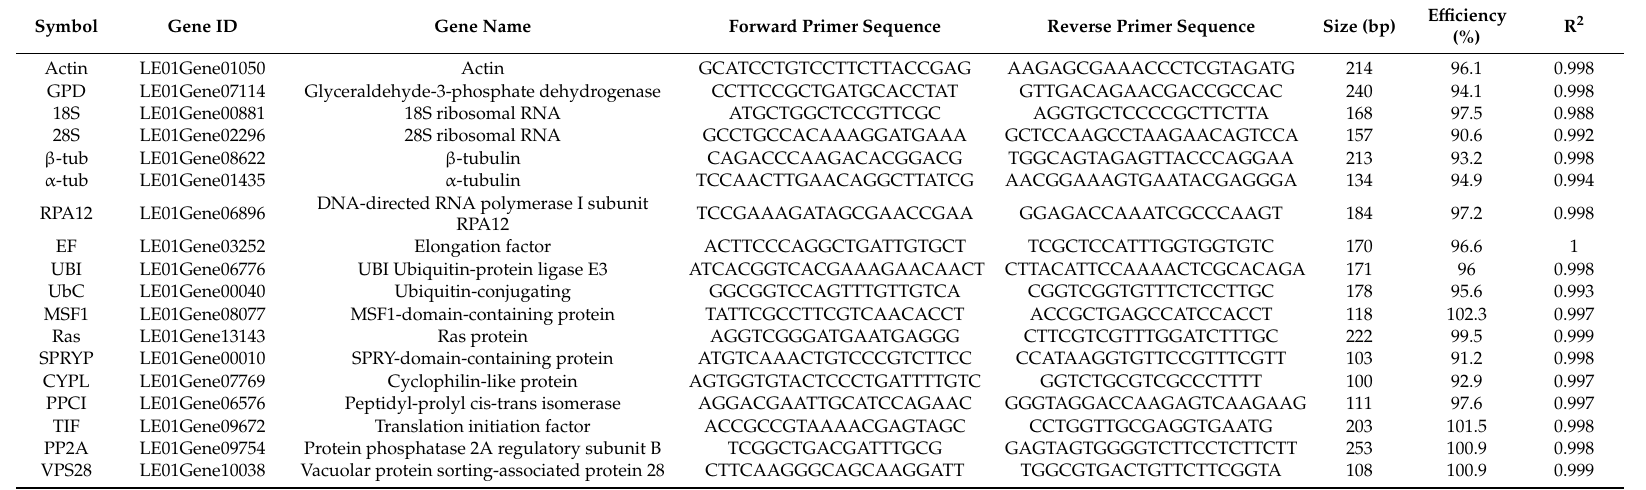
Table 1. Delineations of eighteen candidate candidate reference genes in L. edodes and parameters gained by qRT-PCR